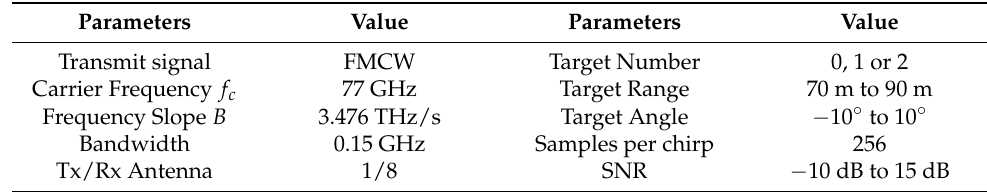
Table 3. Simulation parameters (FMCW—Frequency Modulated Continuous Wave).